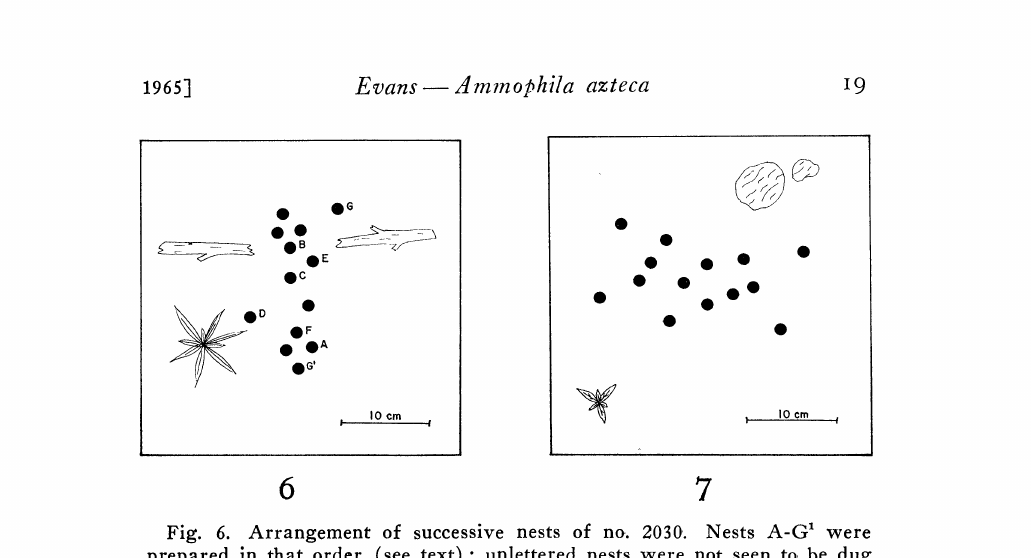
Fig. 6. Arrangement of successive nests of no.. 2030. Nests A-G were prepared in that order (see text) unlettered nests were not seen to, be dug or provisionect and were presumably completed before the beginning o,f intensive ,observations (at least in part). Fig. 7. Arrangement of nests of no. 2031, which nested about 2 meters from the preceding at Jackson